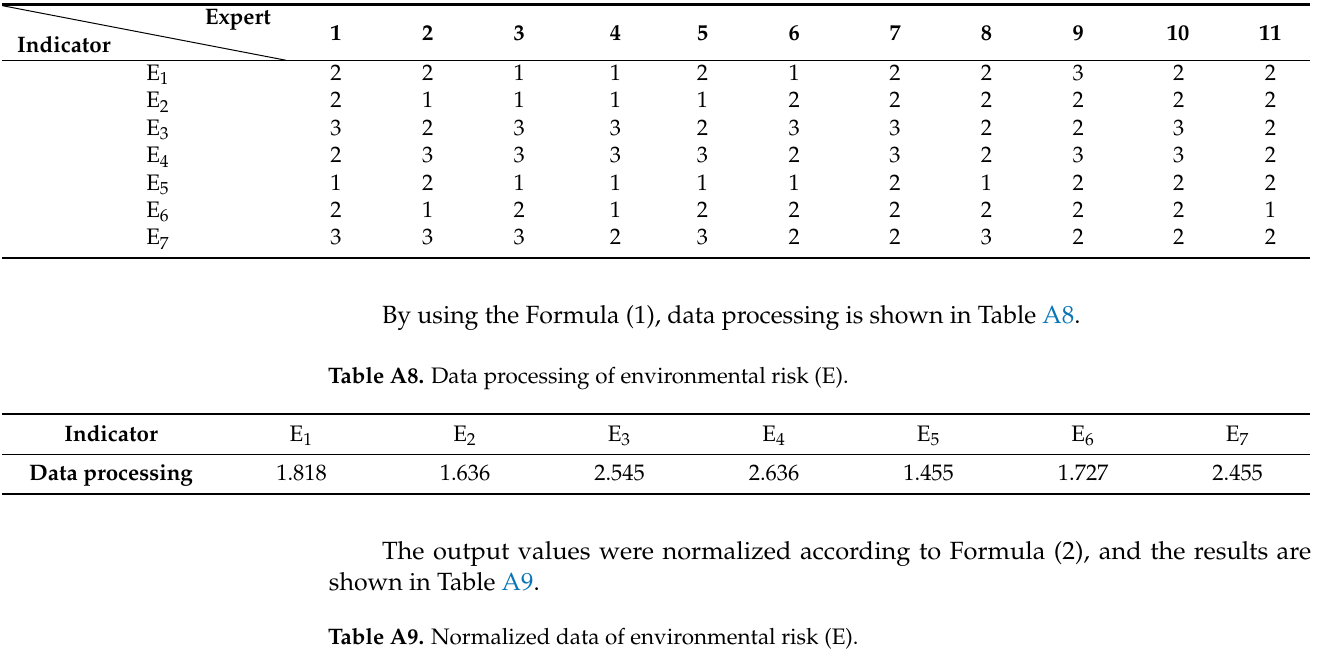
Table A7. Raw data of environmental risk (E).